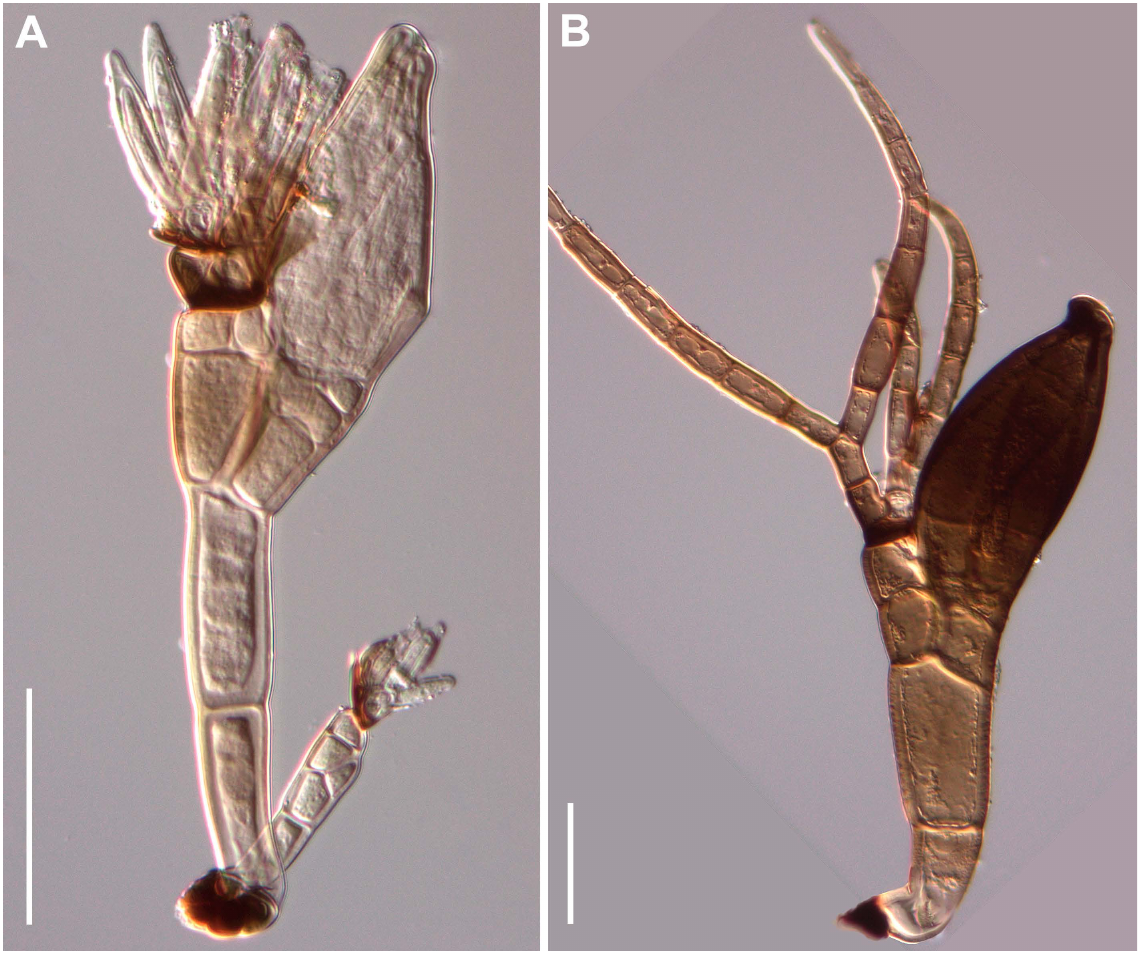
Fig. 30. Laboulbenia spp. A . L. egens Speg. Paired thalli, one mature at left and one immature at right. – B . L. elaphri Speg. Mature thallus. Scale bars: 50 µm. Photographs from slides ZMUC C-F-122883 (A), ZMUC C-F-123141